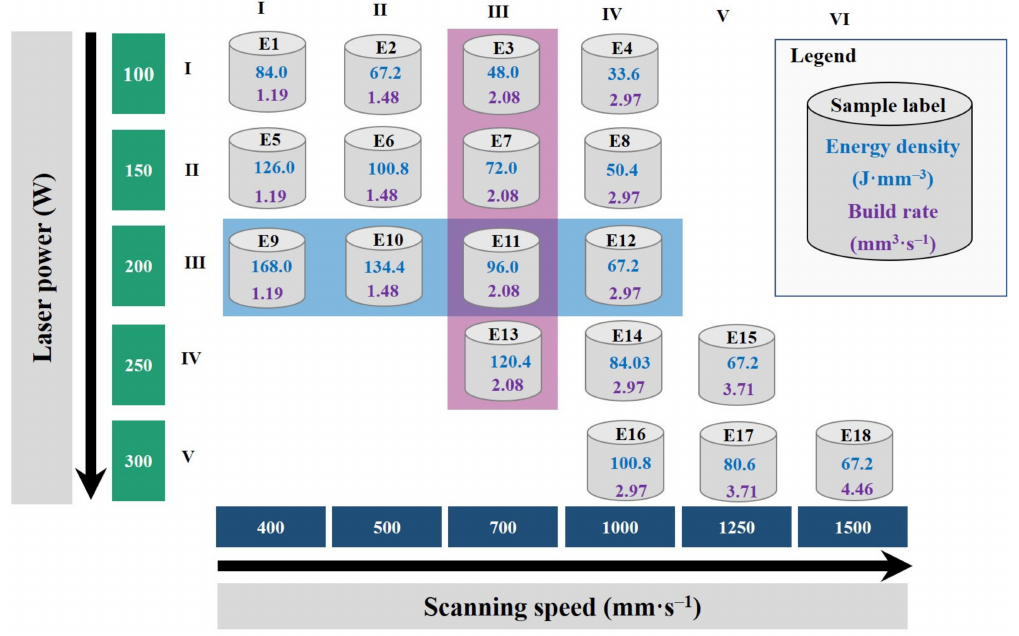
Figure 1. Scheme of used parameters according to scan speed and laser power (Note: The samples highlighted with background blue and purple colors are subjected to microstructural